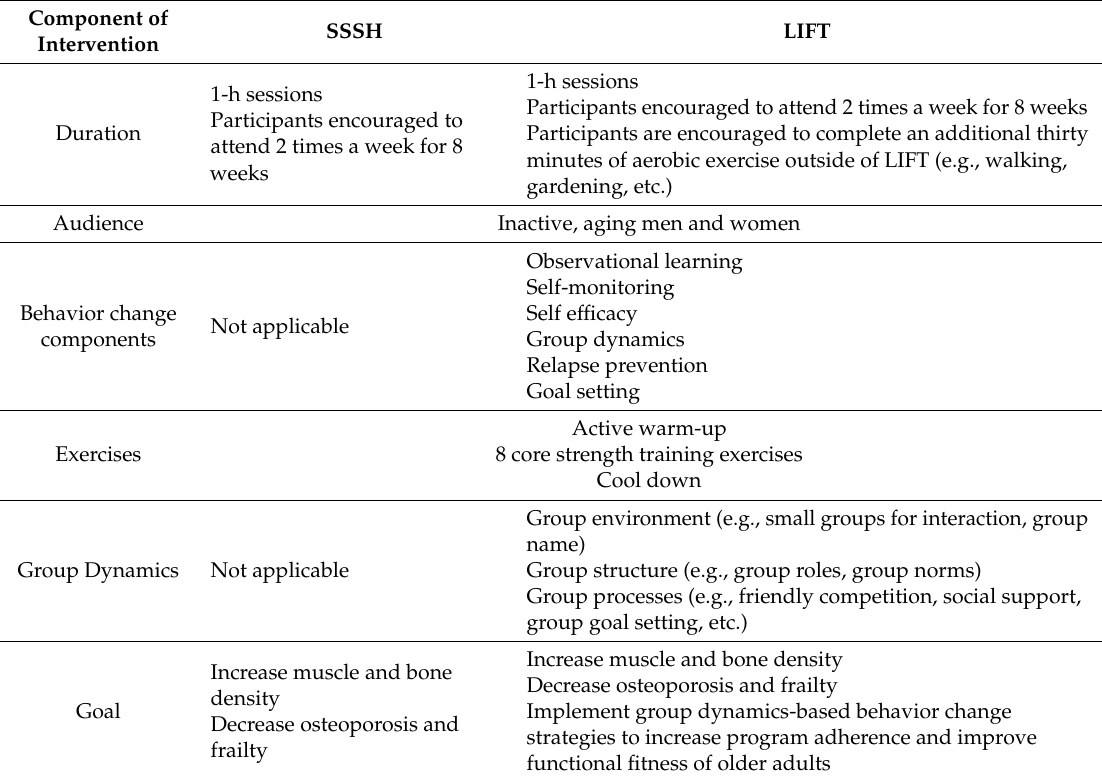
Table 1. Intervention descriptions. Similarities and differences (adaptations made) between Stay Strong, Stay Healthy (SSSH) and Lifelong Improvements through Fitness Together